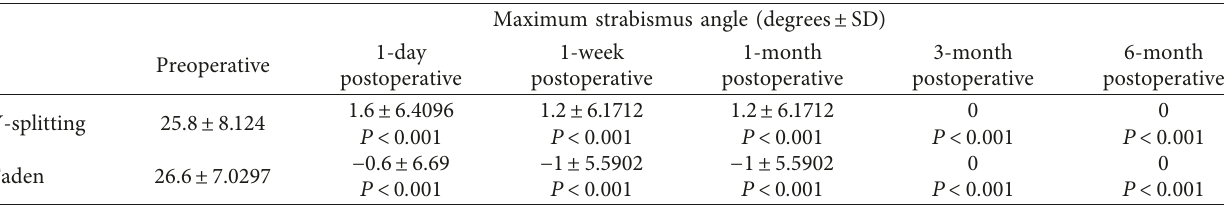
Table 1: The average values of the maximum strabismus angles preoperatively, one day; one week; one, three, and six months postoperatively.